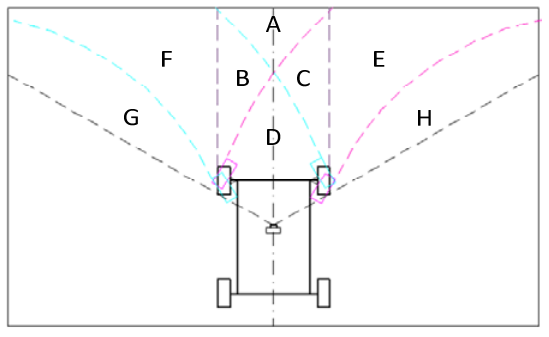
Figure 6. The division of the area in front of the vehicle.